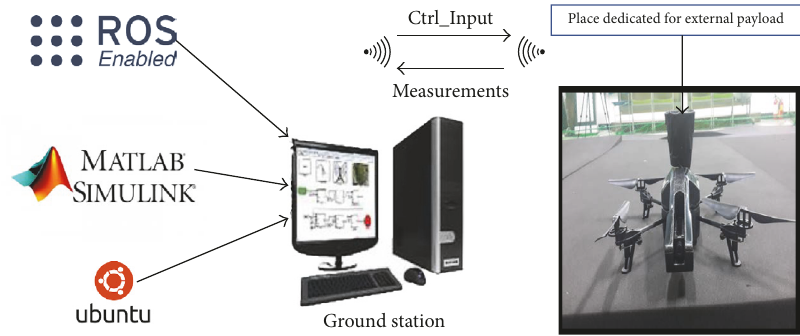
Figure 16: Experimental environment setup.